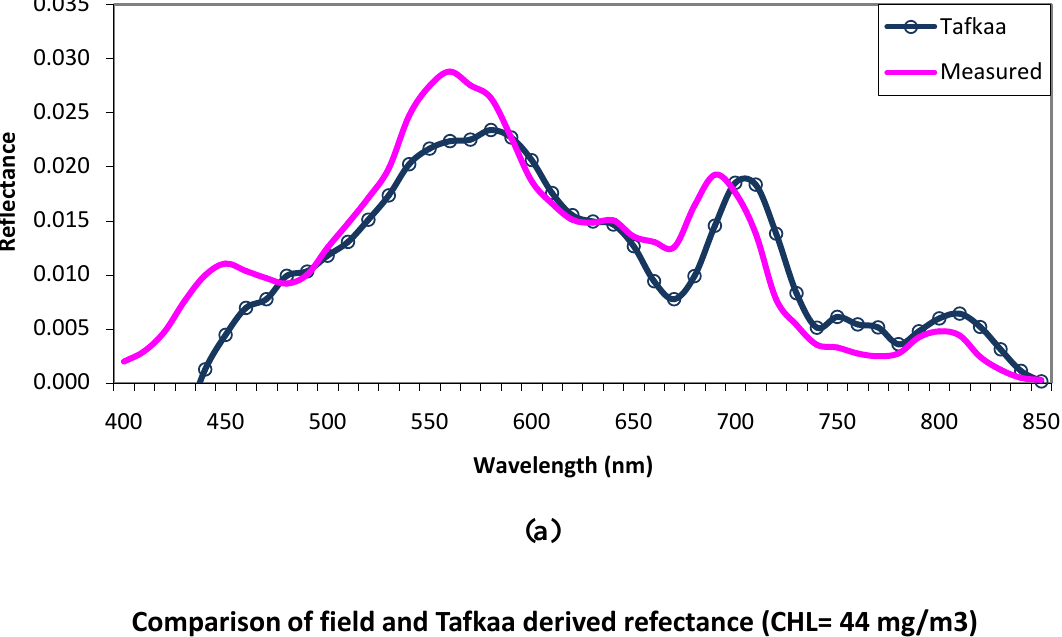
Comparison of field and Tafkaa derived refectance (CHL= 44